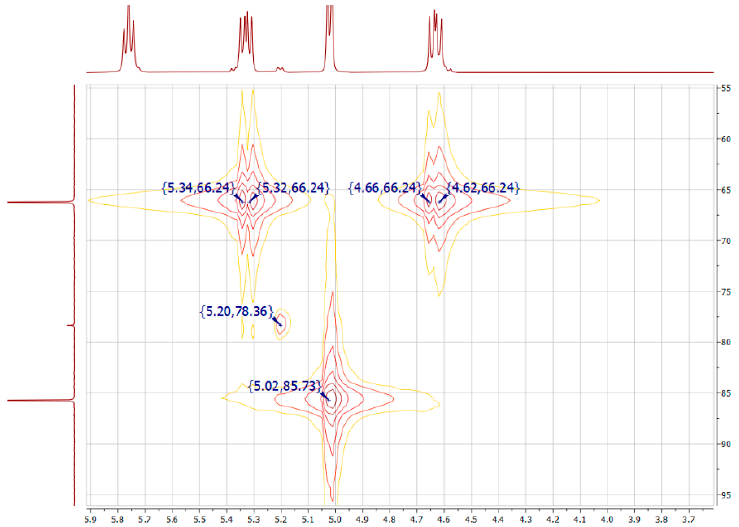
Figure 3. 13 C— 1 H HMQC spectrum for 4,5-dihydroxy-1,3-bis(hydroxymethyl)imidazolidine-2- thione 6 .